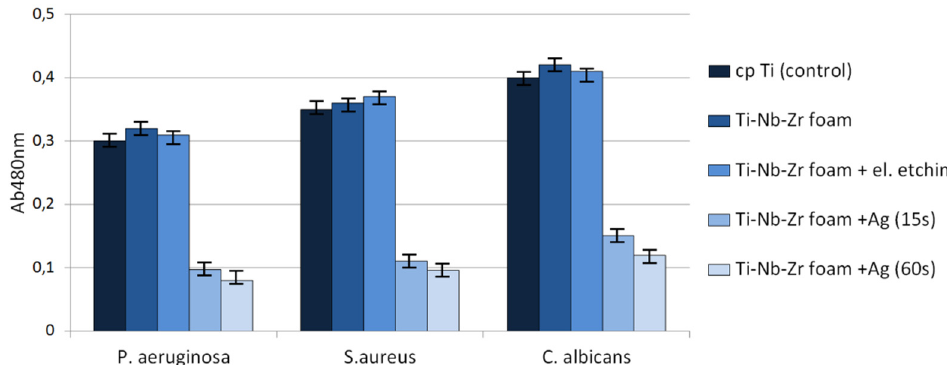
Figure 10. Reduced ability of tested microbes to form a biofilm on the foam surface.